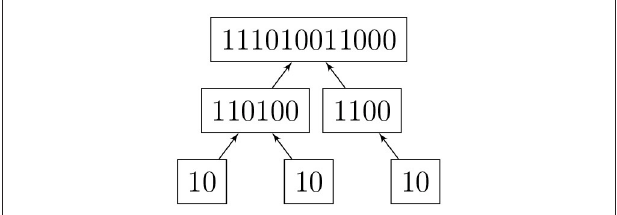
FIGURE 3 | Computing the automorphism group of rooted tree